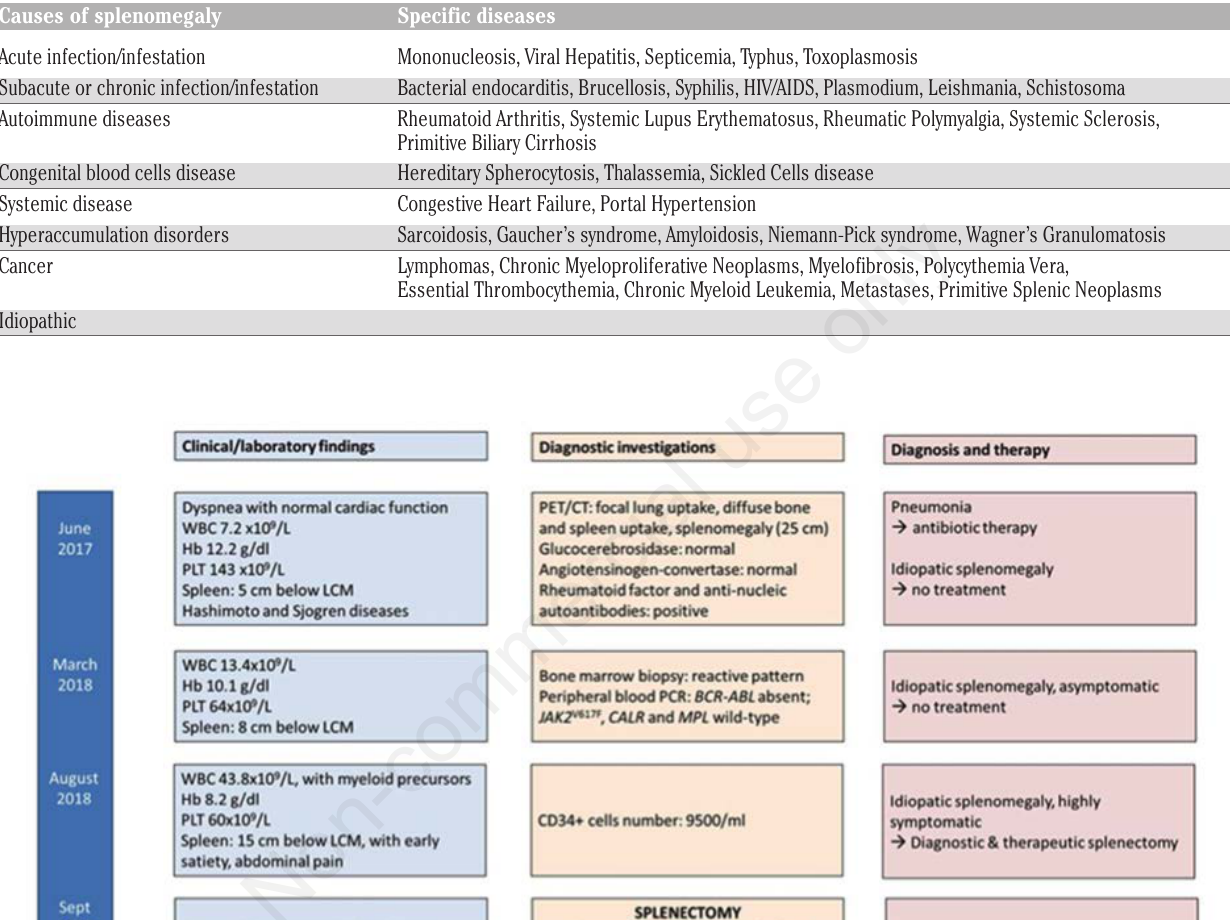
Table 1. Causes of splenomegaly.